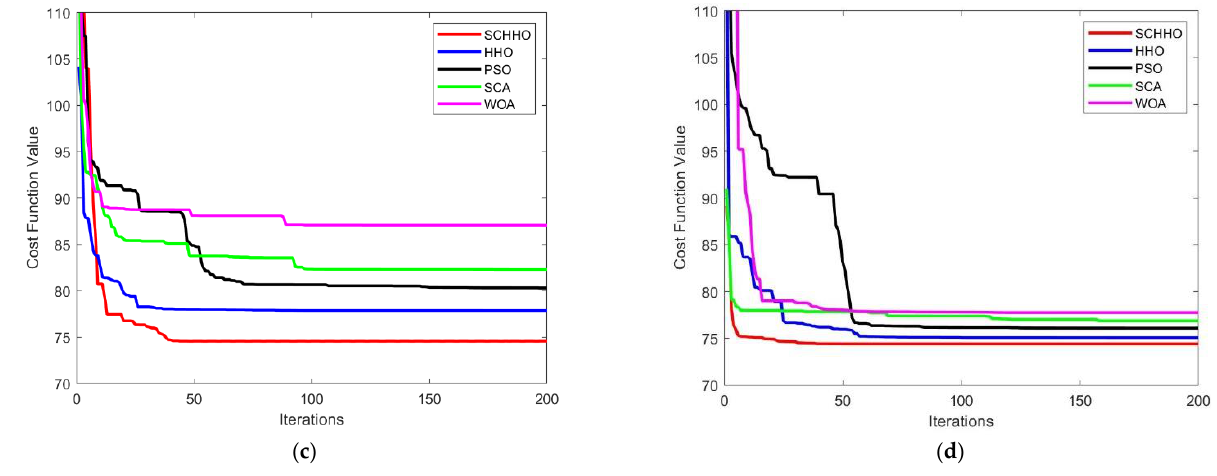
Figure 8. Evolution curves of cost function values. ( a ) Case 1. ( b ) Case 2. ( c ) Case 3. ( d ) Case 4.